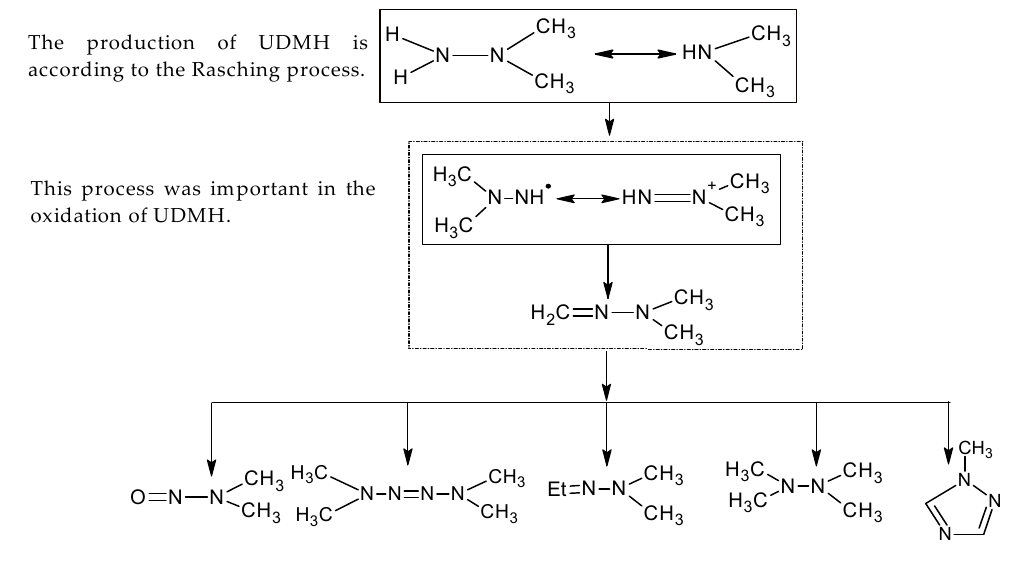
Figure 11. The degradation pathway of UDMH.